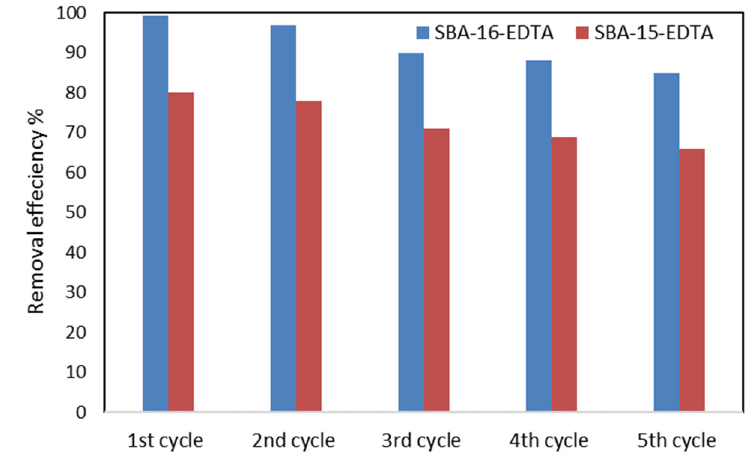
Figure 12. Regeneration and reuse of SBA-16-EDTA and